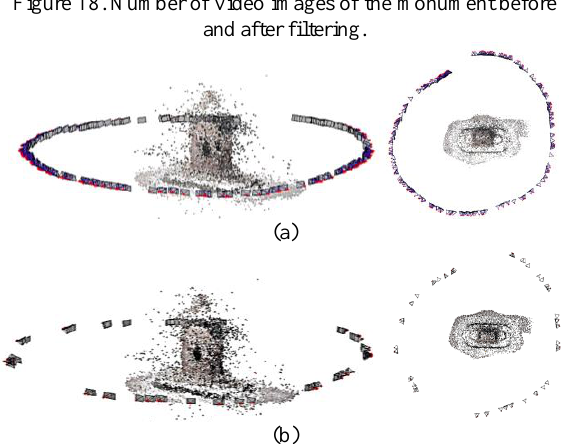
Figure 19. (a) Video camera network of 233 blur-free images. (b) Minimal video camera network of 64